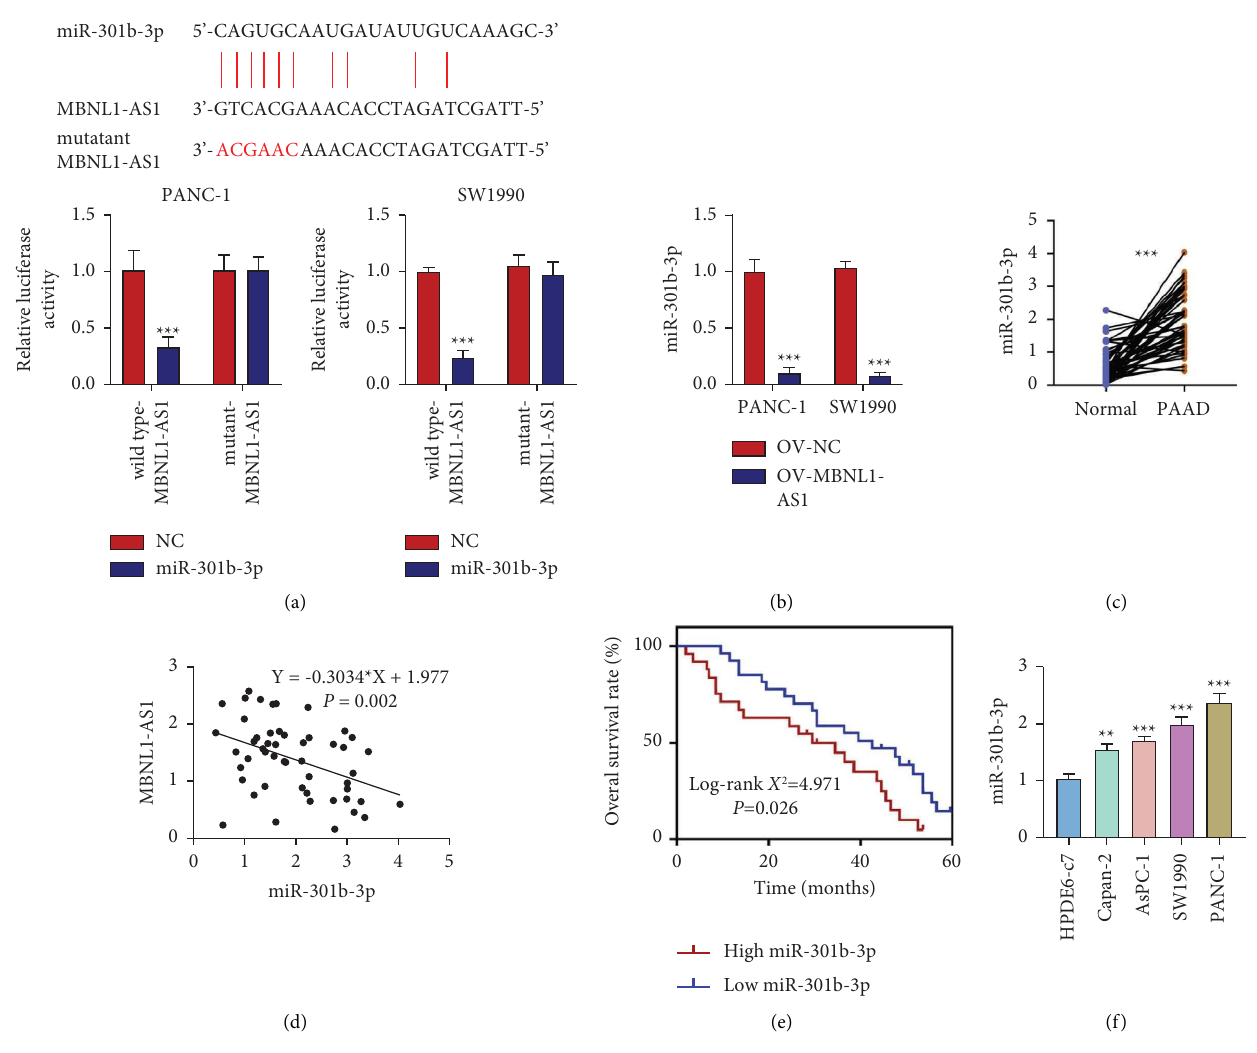
Figure 3: MiR-301b-3p was targeted by MBNL1-AS1 in PAAD. (a) Dual luciferase reporter gene assay was used to verify the targeting relationship between miR-301b-3p and MBNL1-AS1. (b) Te efect of pcDNA-MBNL1-AS1 on the miR-301b-3p expression in PANC-1 and SW1990. (c) Te miR-301b-3p expression in adjacent normal tissues and PAAD tumor tissues. (d) Linear regression analysis of the relationship between miR-301b-3p and MBNL1-AS1 expression. (e) Te overall survival rate of PAAD patients with high miR-301b-3p expression or low miR-301b-3p expression. (f) Te miR-301b-3p expression in diferent cell lines. ∗ P < 0 . 05, ∗∗ P < 0 . 01, and ∗∗∗ P < 0 .